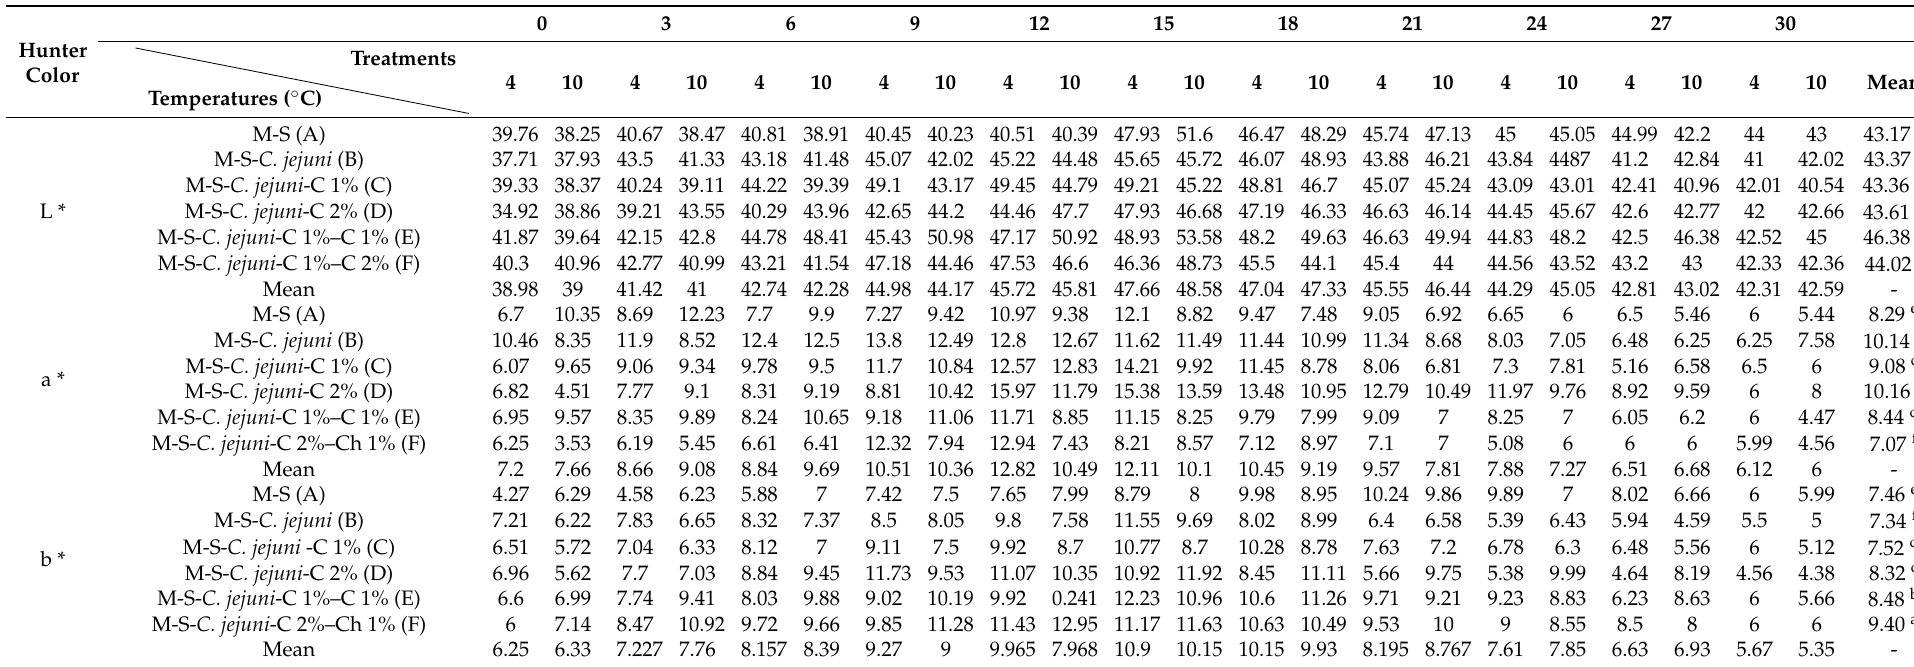
Table 1. Hunter color values of camel meat samples treated with Citrox and chitosan and stored at 4 or 10 ◦ C for 30